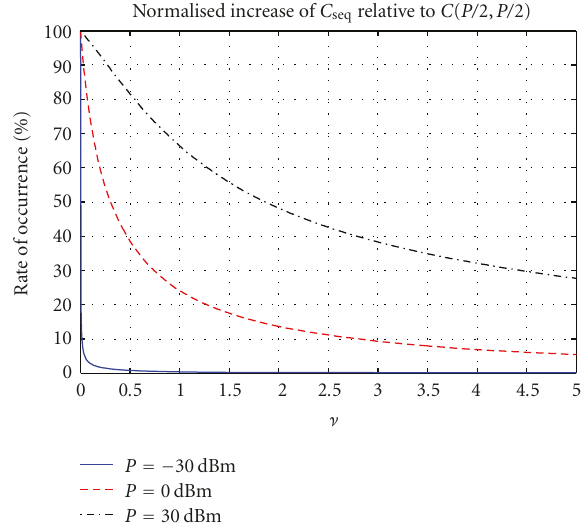
Figure 7: Normalised increase in overall spectral e ffi ciency when simultaneous is preferred over sequential transmission, μ as defined in (34). Disk radius R = 100 m.